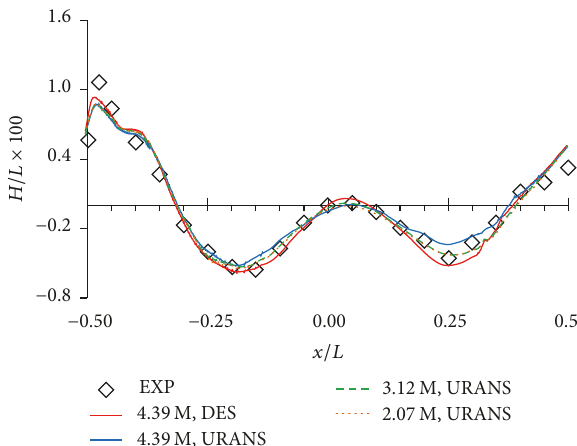
Figure 8: Measured and predicted wave profiles along the hull with different mesh resolutions (Fn = 0.26 ).